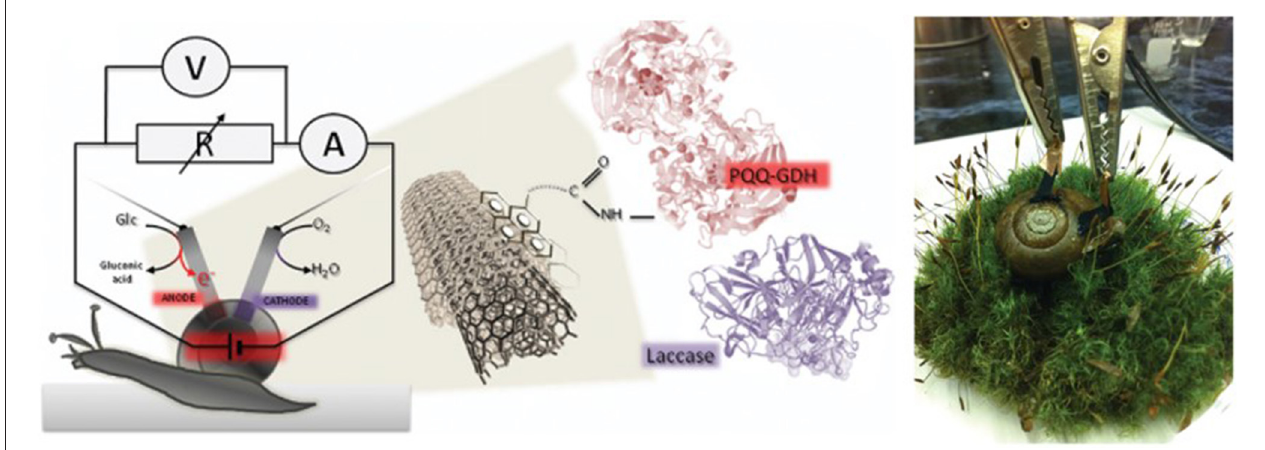
FIGURE 7 | Schematic of enzymatic fuel cell using live snail. Figures are from work by Halámková et al.